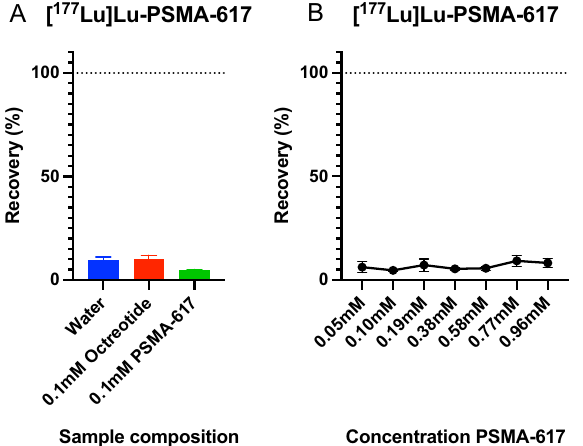
Fig. 4 A Recovery (%) of [ 177 Lu]Lu‑PSMA‑617 diluted in 0.1 mM octreotide, water, or 1.0 mM PSMA‑617. B Recovery (%) [ 177 Lu]Lu‑PSMA‑617 diluted in different concentrations of PSMA‑617. Plotted data are mean and